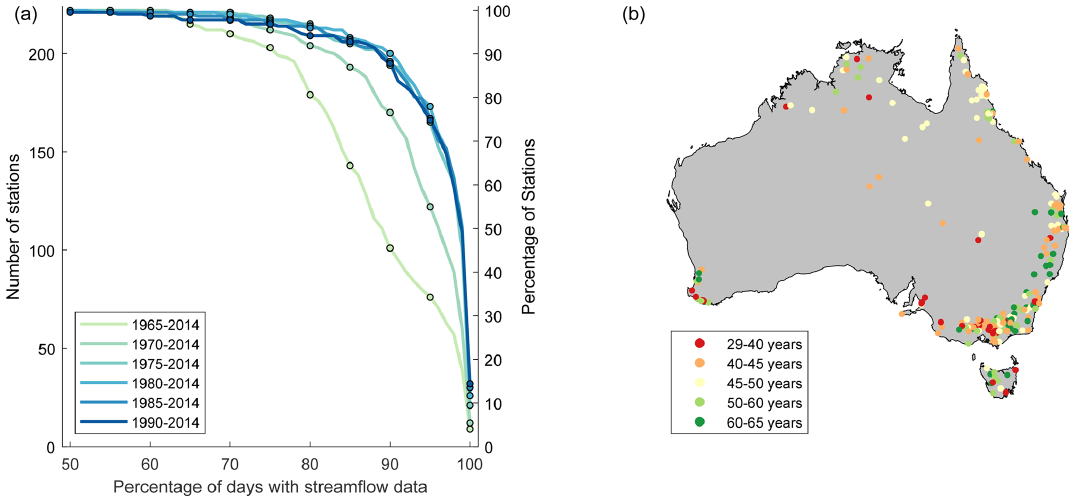
Figure 3. Plot after Coxon et al. (2020) showing (a) number of stations with percentage of available streamflow data for different periods and (b) length of the flow time series for each